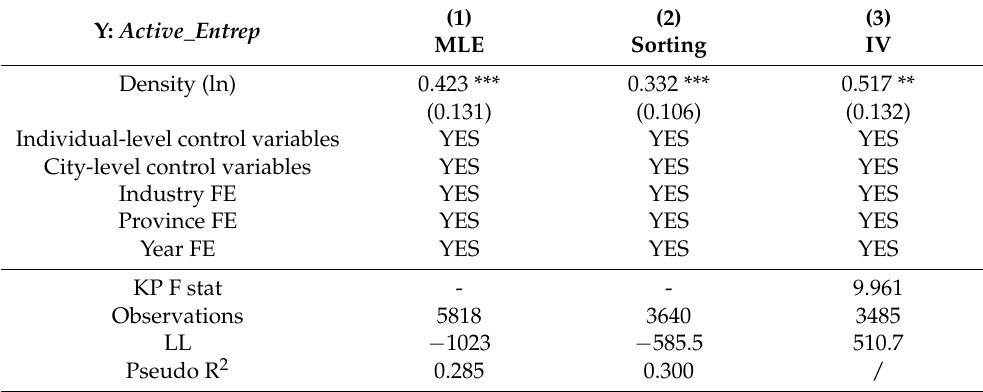
Table 4. Robust check with active